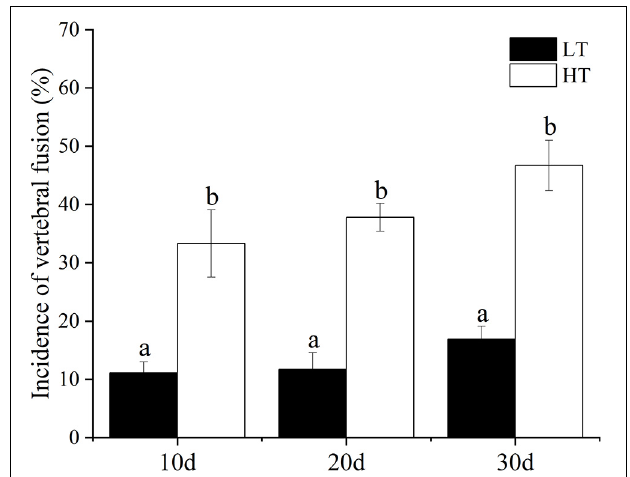
FIGURE 2 | The SGR of juvenile Trachinotus ovatus (LT, low temperature group; HT, high temperature group).